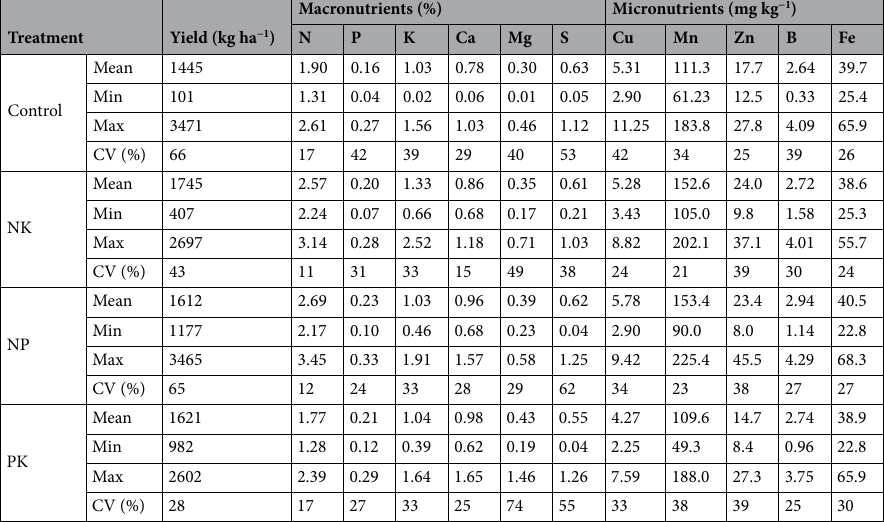
Table 2. Range of maize grain yield and ear leaf concentrations of macronutrients and micronutrients of fertilizer treatments.